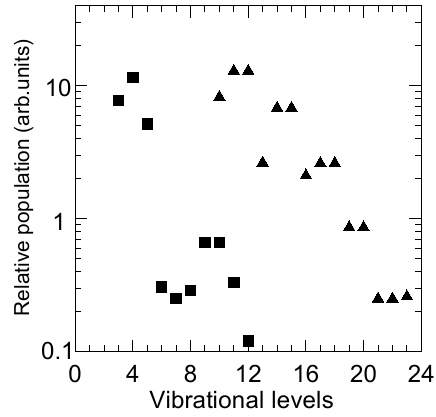
Fig. 2. The calculated populations of A 3 6 + u and W 3 1 u states – triangles and squares, respectively. Figure 2. The calculated populations of A 3 Σ u+ and W 3 ∆ u states – triangles and squares, respectively.